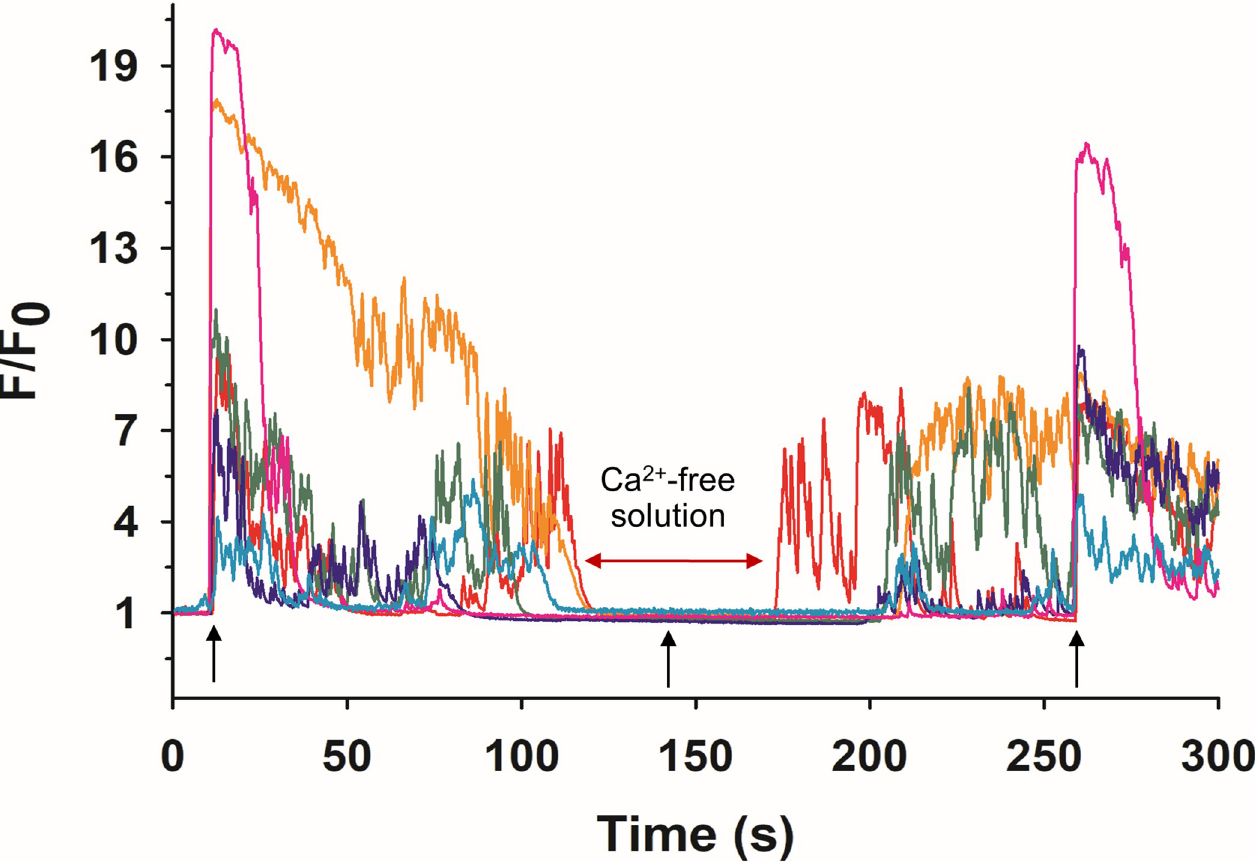
Fig 7. Effect of eliminating extracellular Ca 2+ on 5 ns-elicited Ca 2+ responses in GCaMP6f-expressing ACC. Cells attached to fibronectin-coated glass coverslips were placed in a perfusion chamber. Cells were continuously perfused at a rate of 1 ml/min, first with Ca 2+ -containing BSS, followed by Ca 2+ -free BSS, and again with Ca 2+ -containing BSS. Arrows indicate each time a 5 ns, 8 MV/m pulse was applied to the cells ( n = 3, c = 11).